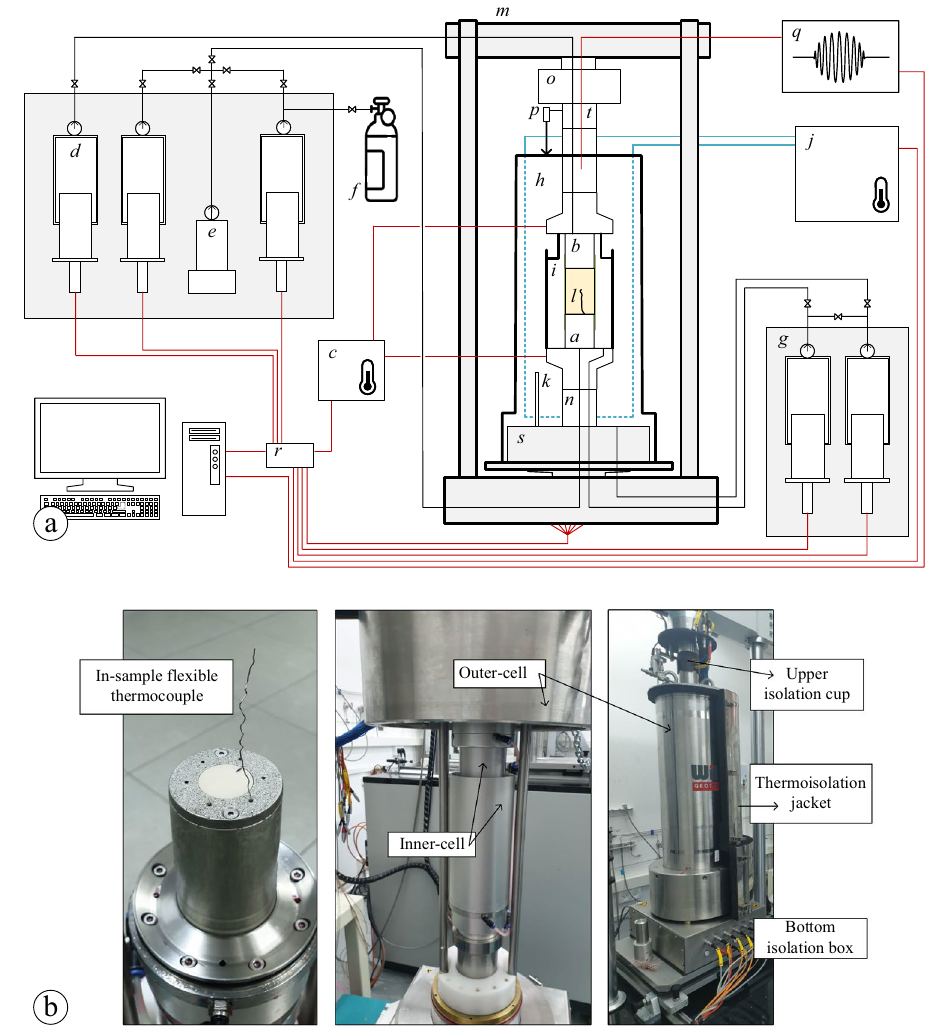
Figure 1. ( a ) An itemized illustration of the experimental setup used in this work ( b ) and photos of selected parts of the